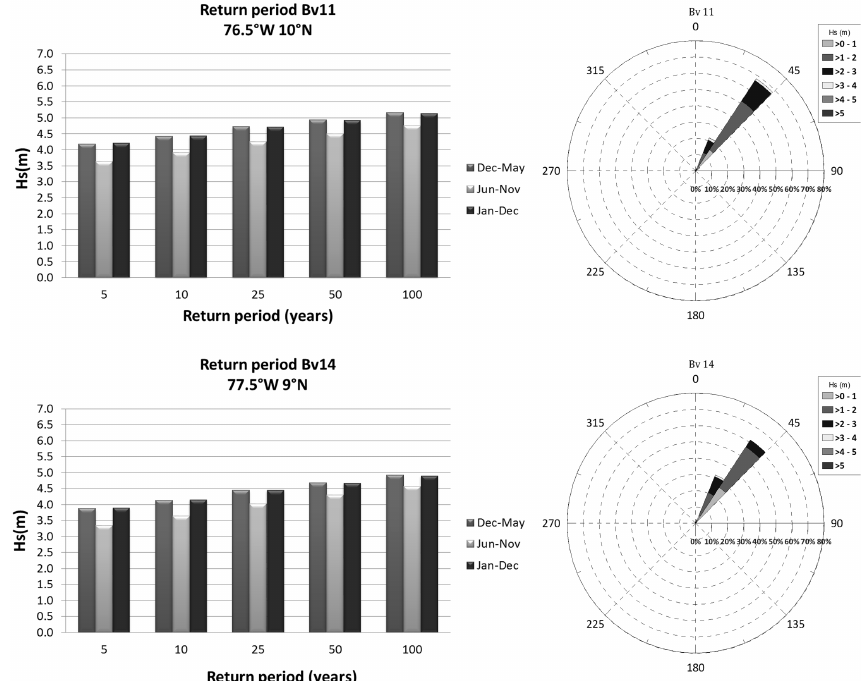
Figure 8. Return period for H s of virtual buoys BV11–BV14 (zone 3).